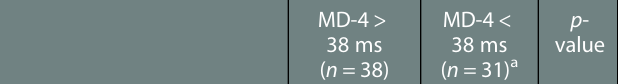
TABLE 4 RV functional and synchronicity parameters in ToF patients with and without greater degree of RV